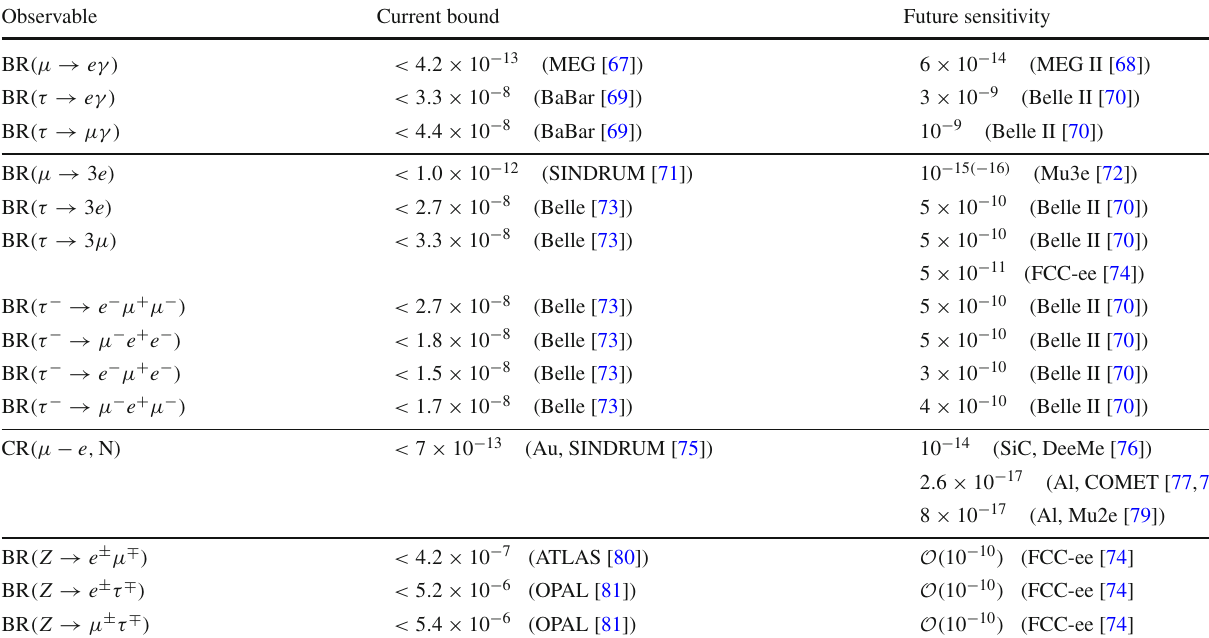
Table 1 Current experimental bounds and future sensitivities on cLFV observables considered in this work. All limits are given at 90%C . L . , and the Belle II sensitivities correspond to an integrated luminosity of 50ab − 1 Observable Current